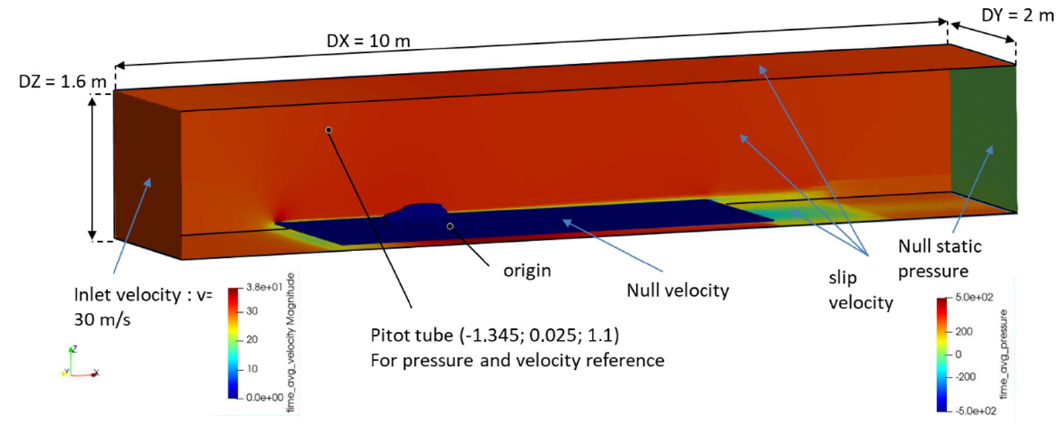
Figure 6. Description of the boundary conditions used for CFD computations.